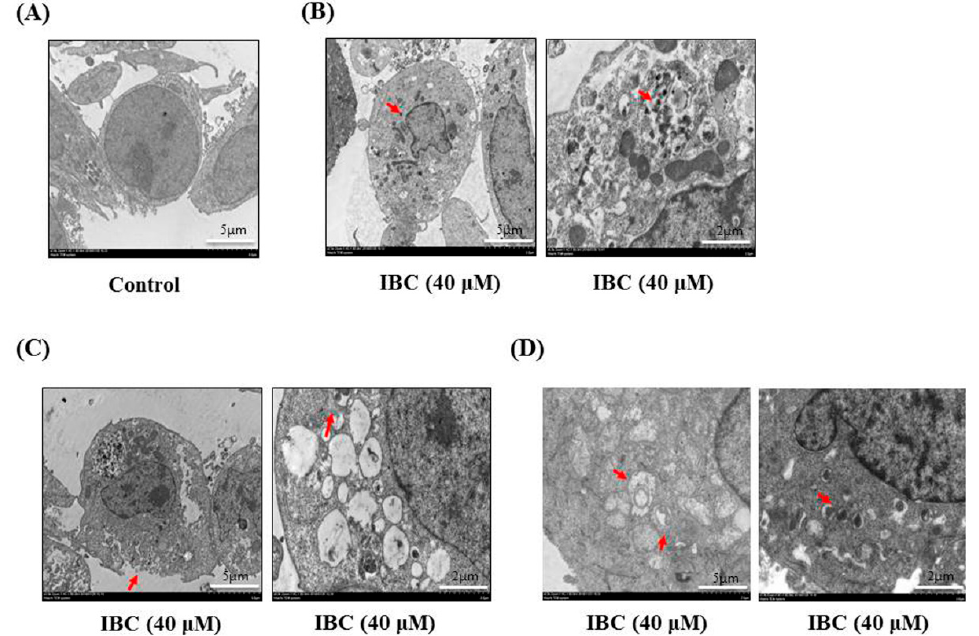
Figure 5. Electron microscopy of MDA-MB-231 cells treated with IBC (40 µM) for 24 h. ( A ) Morphological characteristics of control. ( B ) Morphological characteristics of IBC-treated MDA-MB-231 cells showing apoptosis. Red arrowheads indicate bright nuclear condensation. ( C ) Morphological characteristics of IBC-treated MDA-MB-231 cells showing necroptosis. Red arrowheads indicate cell membrane integrity and swelling of cellular organelles. ( D ) Morphological characteristics of IBC-treated MDA-MB- 231 cells. Red arrowheads indicate